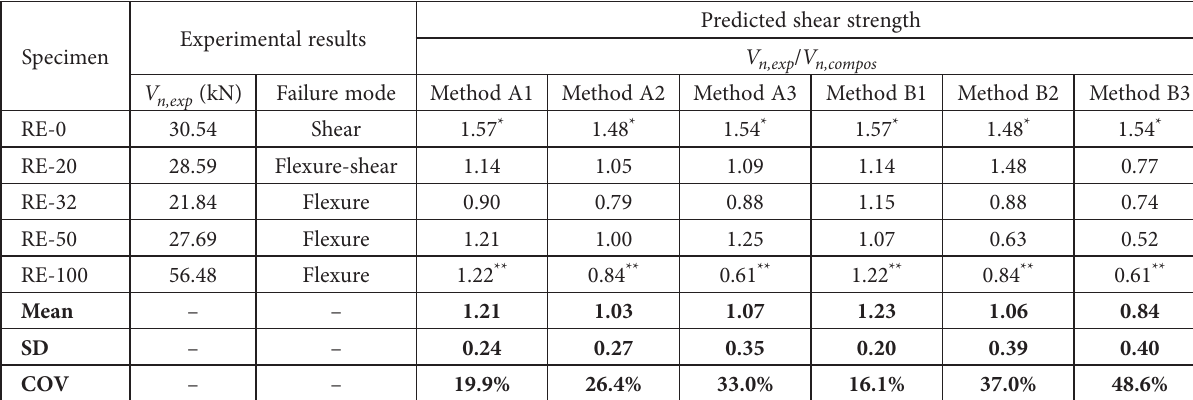
Table 4. Predicted and experimental shear strength results (RE series)